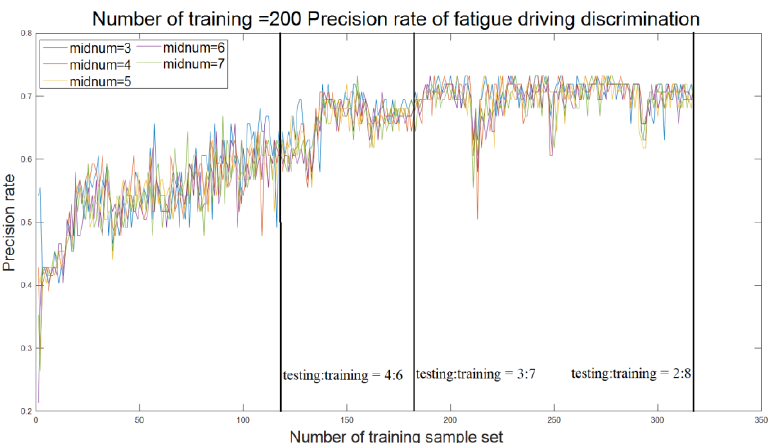
Figure 6. Accuracy of fatigue driving behavior detection varying with the number of training samples when the training times is 100.